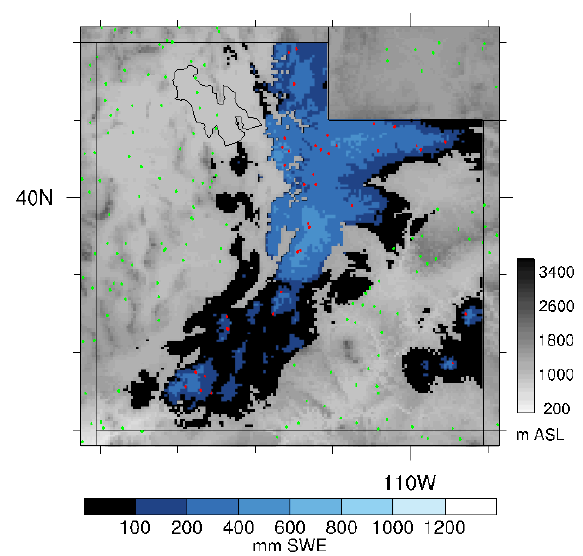
Figure 3. Sample regridded April 1 SWE. Red points indicate the locations of snow courses, green points indicate the locations of dummy observations used in zero-padding conditioning prior to Cressman interpolation.